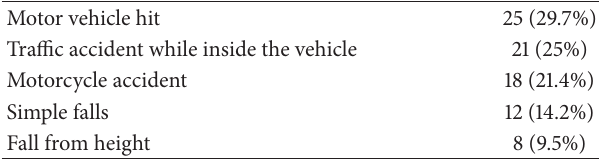
Table 2: Reasons of trauma.